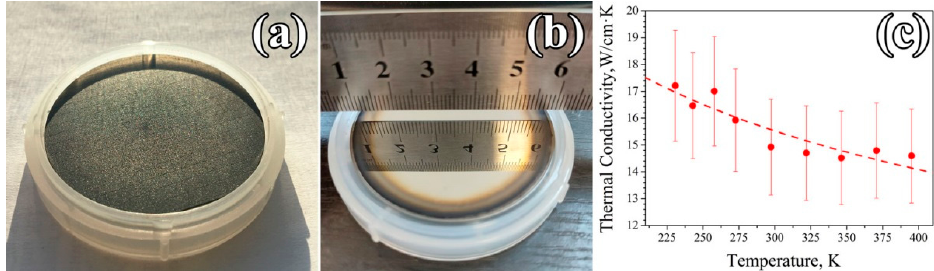
Figure 7. Photographs of the 2-inch “diamond-on-Si” sample with the thickness of PCD layer of 100 μ m: ( a ) PCD top surface, ( b ) Si substrate bottom surface; ( c ) temperature dependence of TC for the final PCD plate with the thickness of 200 μ m after the complete chemical removal of the Si substrate. The line is the guide for the eye.